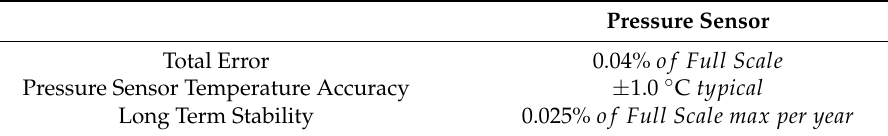
Table 2. Pressure sensor specifications (Honeywell IPT).